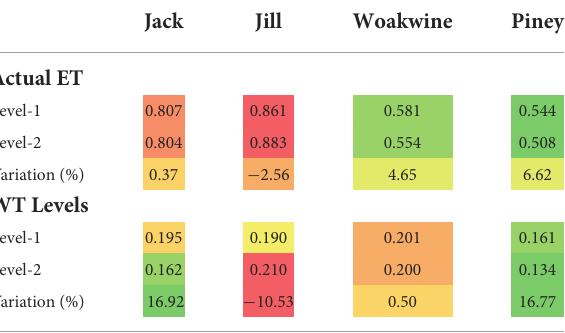
TABLE 4 CRPS values for the two stochastic simulation levels and relative percentage variation of Level–2 over Level–1. Jack Jill Woakwine